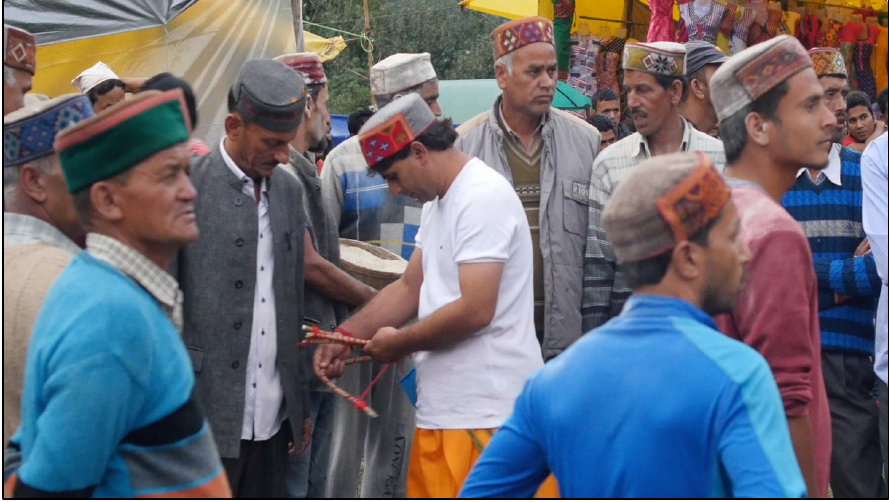
Figure 7. The kardar prepares to sacrifice ( Narbali ).